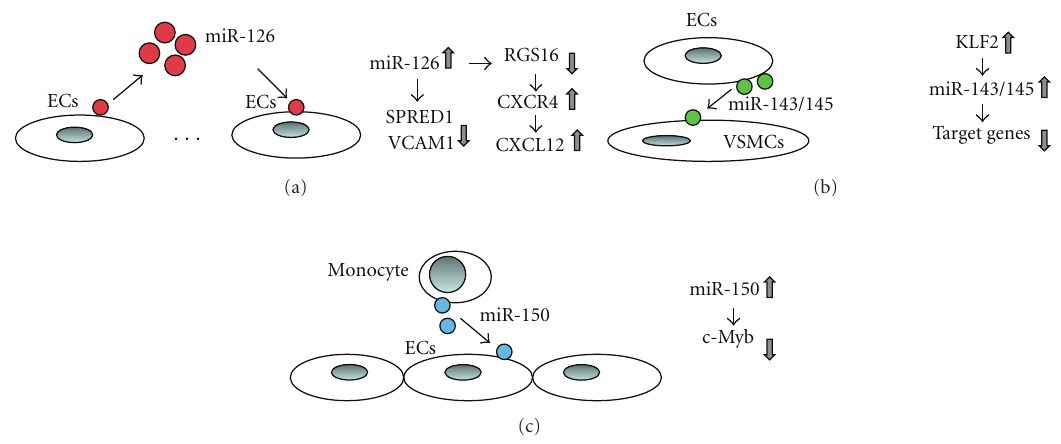
Figure 4: Cell-to-cell communication. ECs are involved in cell-to-cell communication. Schematic representation of three reported communications is shown. (a) ECs-derived apoptotic bodies are transferred to recipient ECs. These apoptotic bodies contain miR- 126 that suppress RGS16 expression, enabling CXCR4 to induce CXCL12 production. miR-126 can suppress SPRED1 and VCAM-1 expressions. (b) Shear stress stimulated ECs released miR-143/145 enriched microvesicles, which are transferred into VSMCs. (c) miR- 150 is selectively loaded into monocyte derived microvesicles. These microvesicles are transferred to ECs and inhibit c-Myb expression in